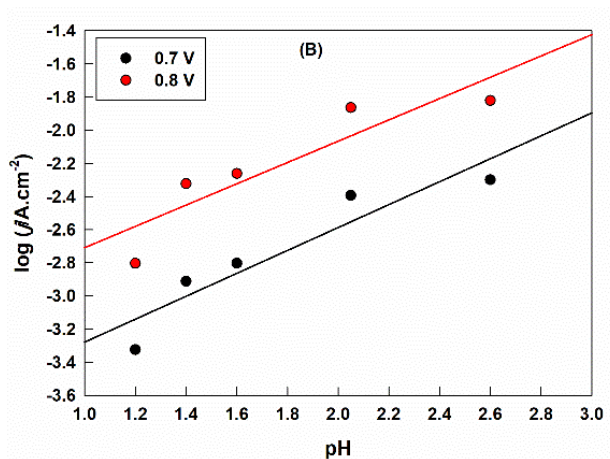
Figure 3. The ( A ) potentiodynamic polarization of GC/Sr 2 PdO 3 in different concentrations of the HClO 4 solutions and ( B ) the dependence of the logarithm of the current density at a definite potential on the pH of the solution.